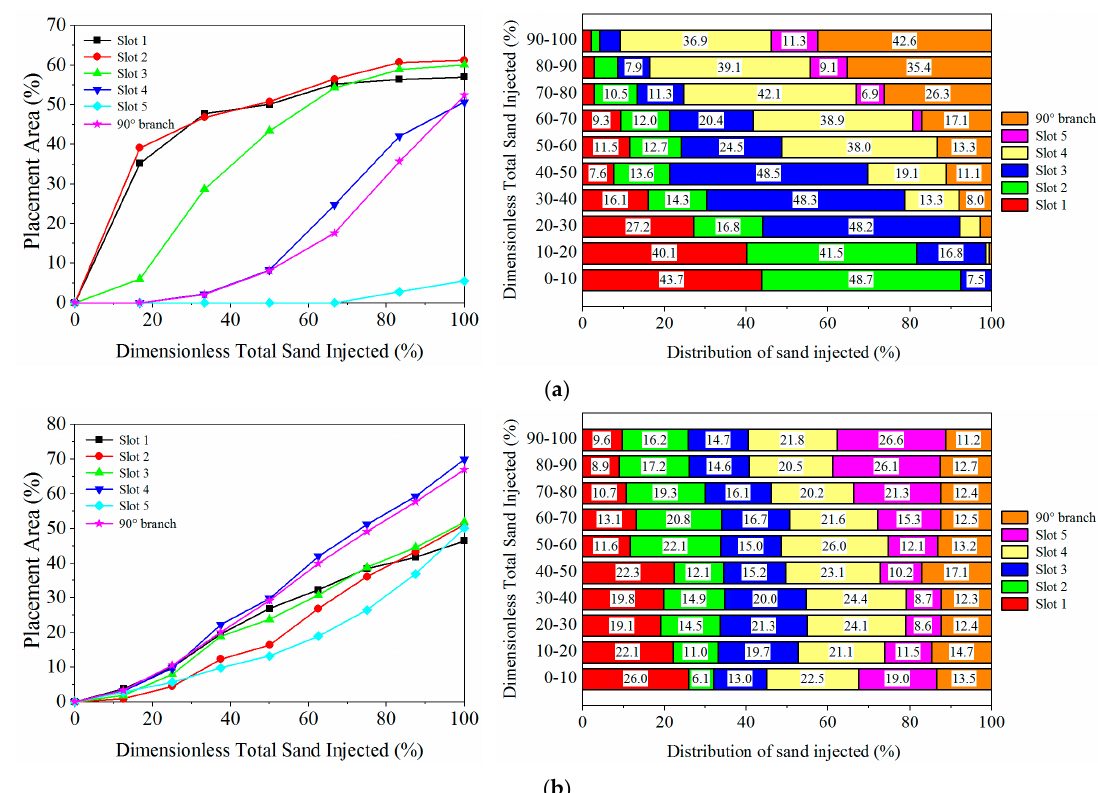
Figure 6. Evolvement of the dunes under different sand sizes, ( a ) case 7 under 16/20 proppants, ( b ) case 10 under 70/140 proppants.